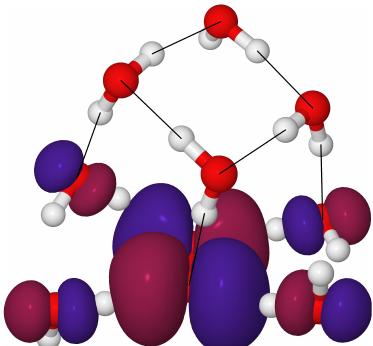
Fig. 7. Plot of HOMO orbital of the O − bonds are indicated by black lines. Electronic density cutoff is 0.02 e/a 3 . The delocalization of the excess charge onto the 4 closest 0 H 2 O is apparent.